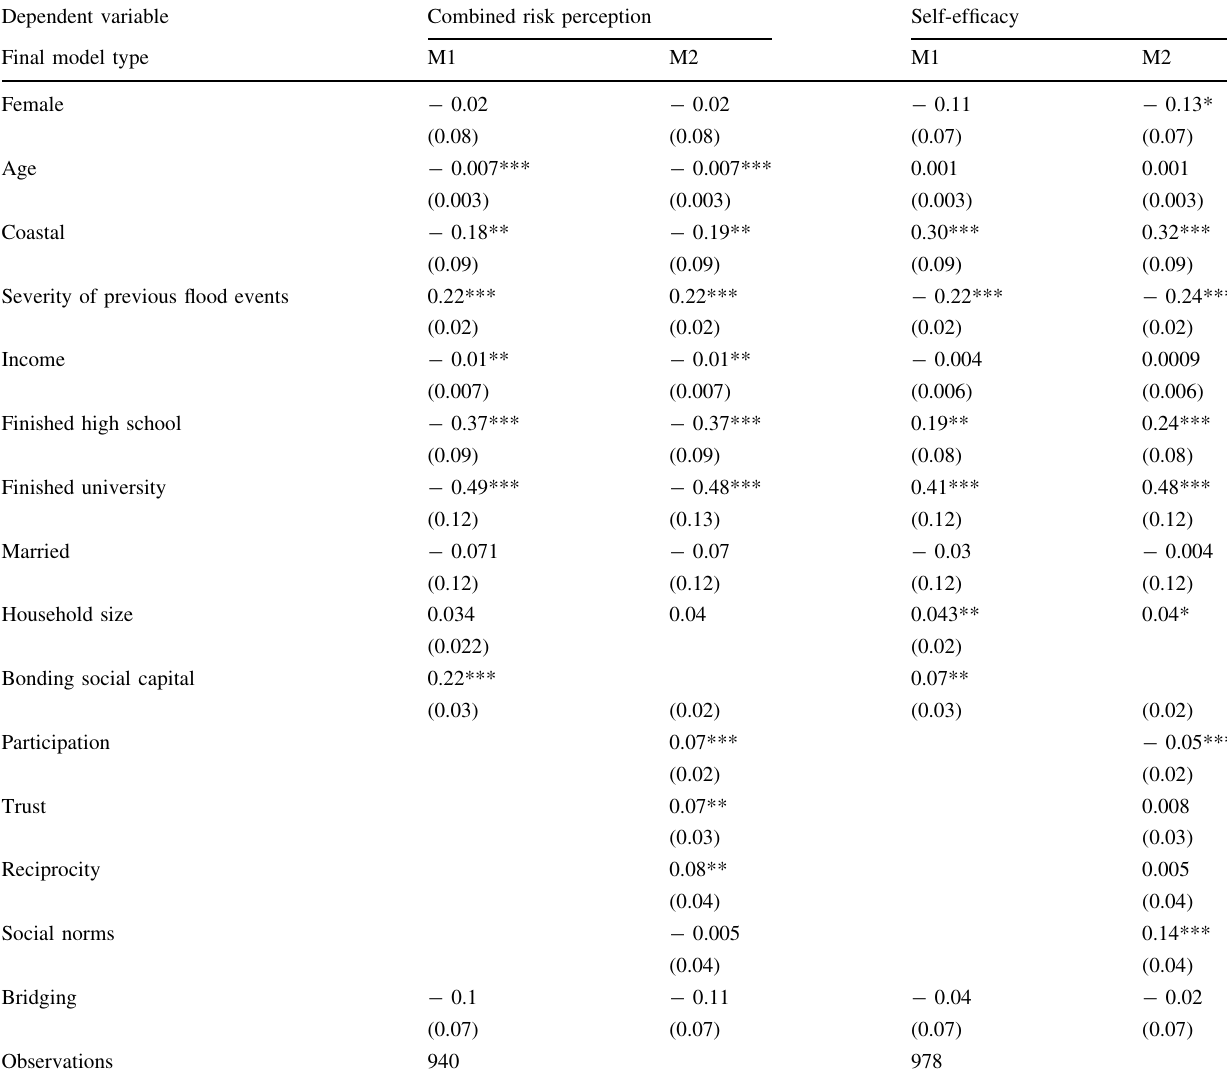
Table 2 Estimated regression coefficients between risk perceptions, self-efficacy, and social capital Dependent